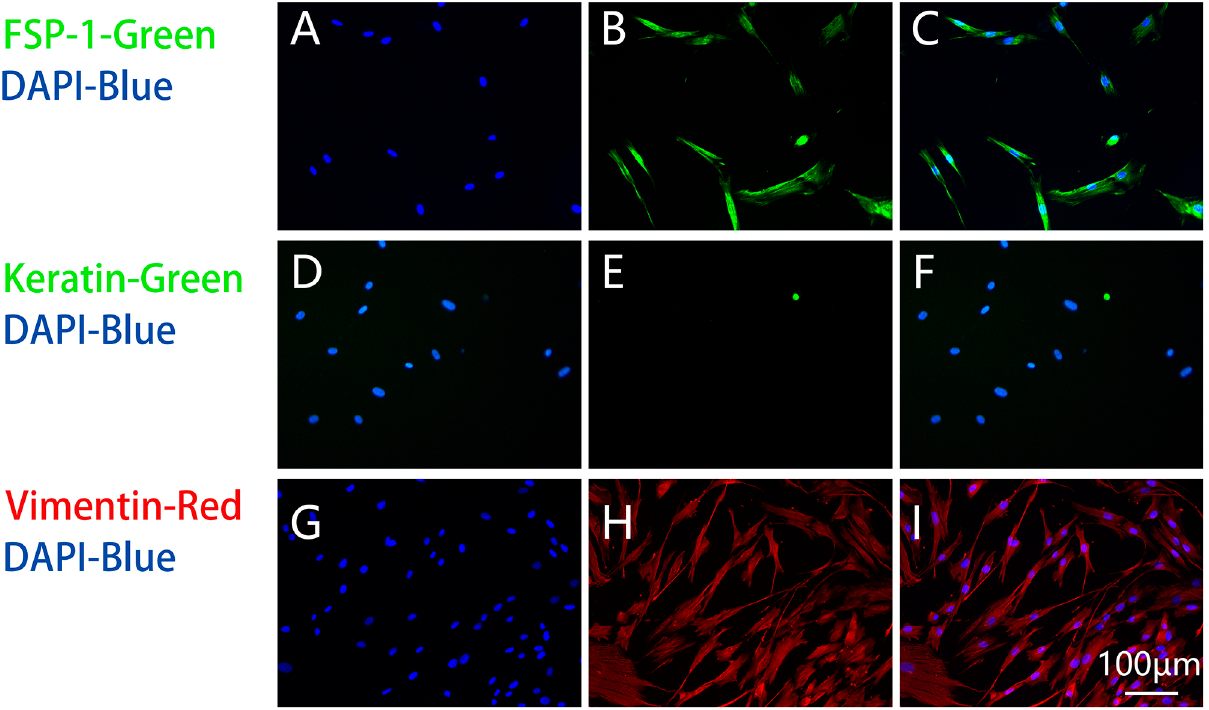
Figure 3- Identification of the second passage cells from HGFs with immunofluorescent staining.(A-C) The green positive expression of FSP-1 in the cytoplasm of HGFs.(D-F) Keratin is unstained in the cytoplasm.(G-I) The positive staining of vimentin in the cytoplasm of HGFs was red fluorescence. The positive staining of nucleus of HGFs was blue fluorescence. Scale bar =100μm. Fluorescence microscope × 200